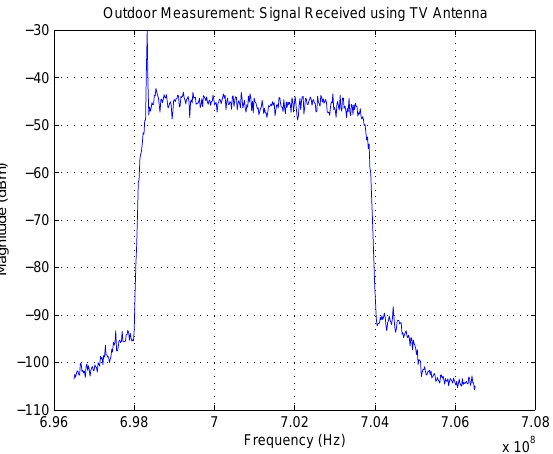
Figure 6. Digital TV Signal. Pilot is noticed in the